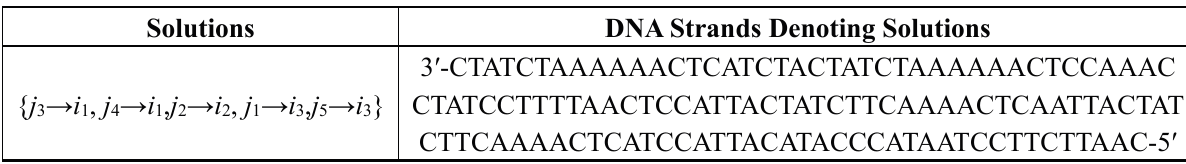
Table 12. DNA sequences chosen to represent the answer of the unbalanced assignment